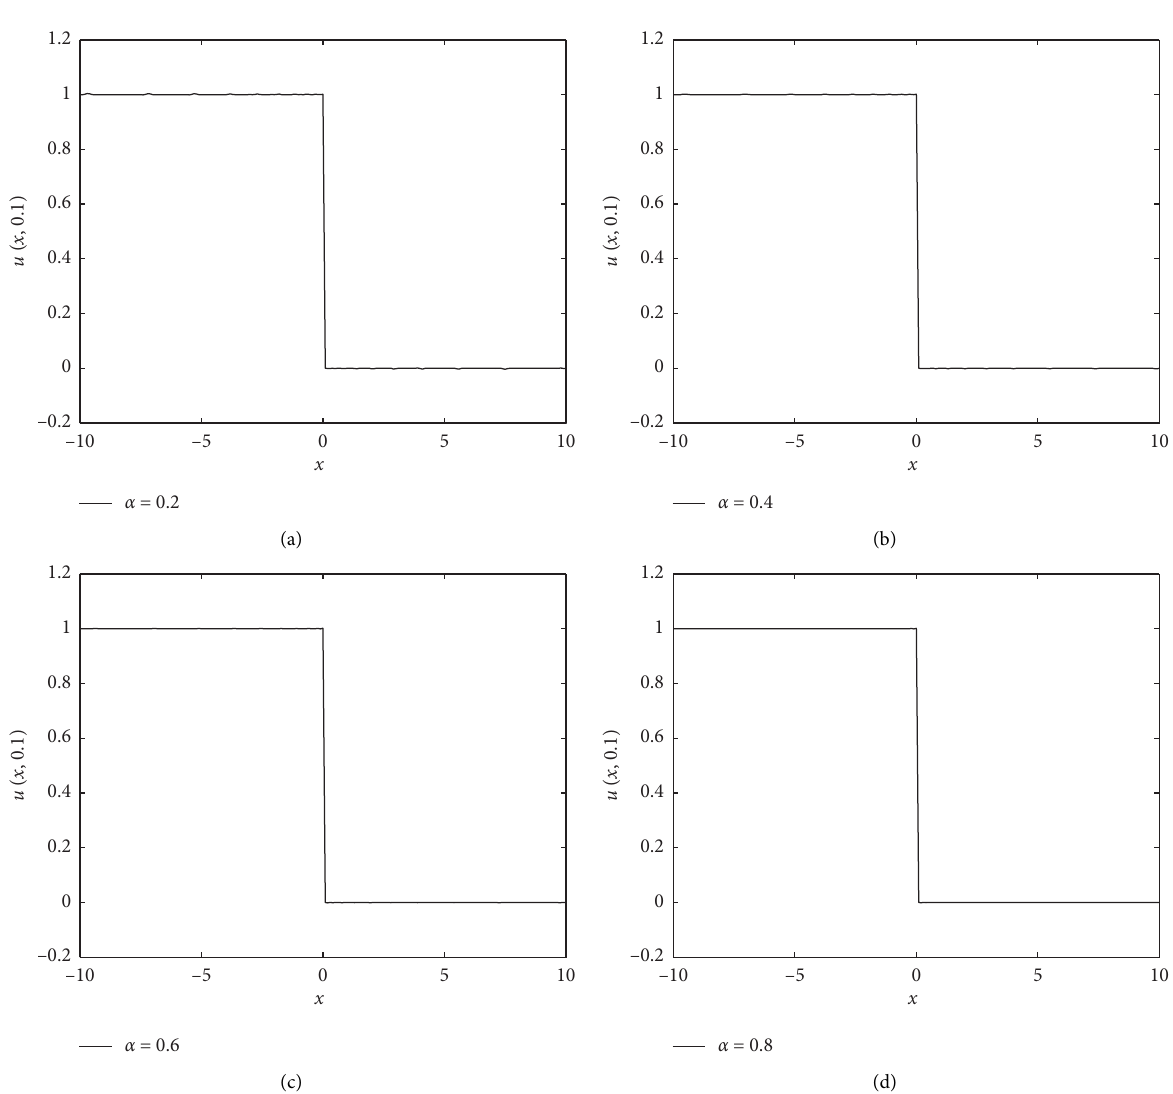
Figure 3: Numerical solutions of Example 3 with N � 200and σ � 0 . 1 for different orders of fractional derivatives at T � 0 . 1. (a) α � 0 . 2, (b) α � 0 . 4, (c) α � 0 . 6, and (d) α � 0 .